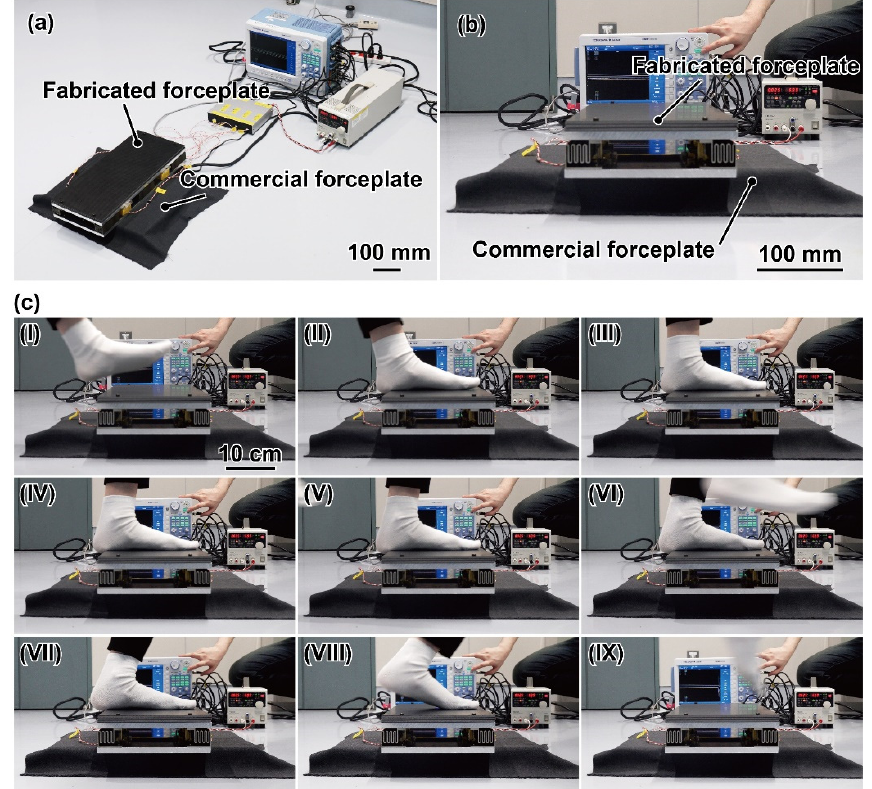
Figure 11. ( a , b ) Photographs of the experimental setup to demonstare the GRF measumement during walking. ( c ) Camera image during the experiment. The time interval is 0.1 ms. ( cI ) Camera image before the sole contacts the FP. ( cII – cVIII ) Camera image while FP is in contact with the sole. ( c-IX ) Camera image after the sole contacts the FP.